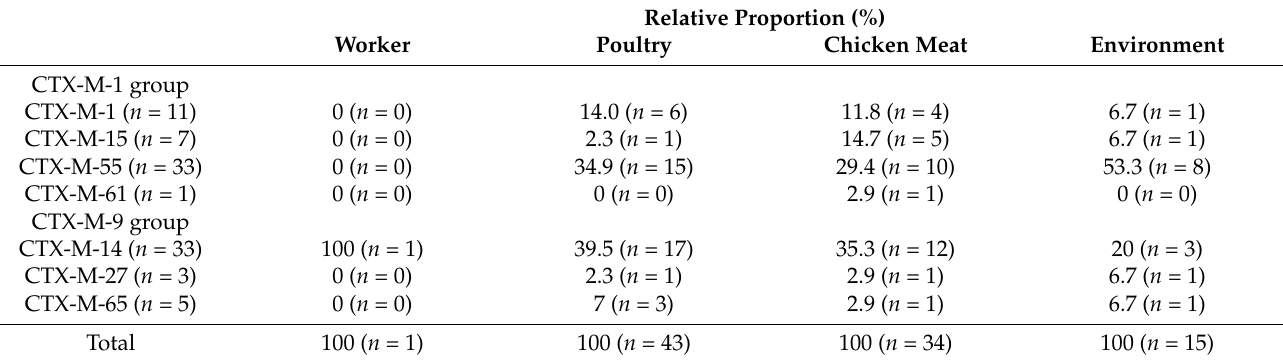
Table 2. Relative proportion of PCR-determined genotypes of ESBL-EC isolates from poultry industry-related samples (N =